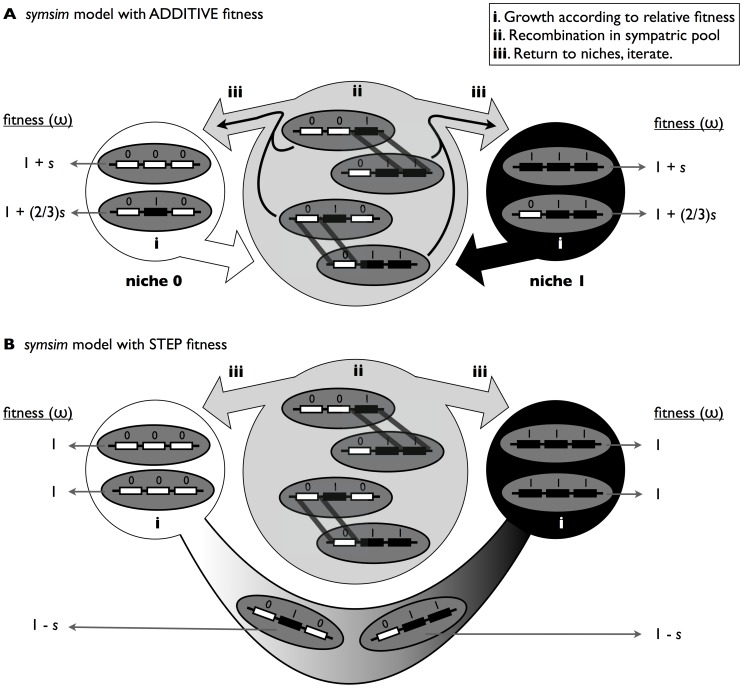
Schematic of the symsim model.(A) Additive fitness. The steps of the simulation are (i) growth/selection according to relative additive fitness within each niche, (ii) small probability of recombination (r) by gene conversion of homologous loci (diagonal lines) in a sympatric, mixed pool of genotypes from both niches, and (iii) individuals return to the niche to which their genotype is best adapted (e.g. in this 3-locus example, genotypes 000 and 010 go to niche 0, while 111 and 011 go to niche 1). Steps (i), (ii) and (iii) are iterated for a set number of generations or until any of the derived alleles go extinct. (B) Step fitness. The steps of the simulations are the same as for additive fitness, except that individuals can grow and be selected in both niches. Optimally adapted genotypes (111 and 000) compete in just one niche. Intermediates compete in both niches, but pay a fitness cost s for niche switching. In the example shown, an individual of genotype 010 obtains 2/3 of its resources in niche 0 (and adds a count of 2/3 of an individual to the population size of niche 0), and 1/3 from niche 1 (and adds a count of 1/3 of an individual to niche 1).